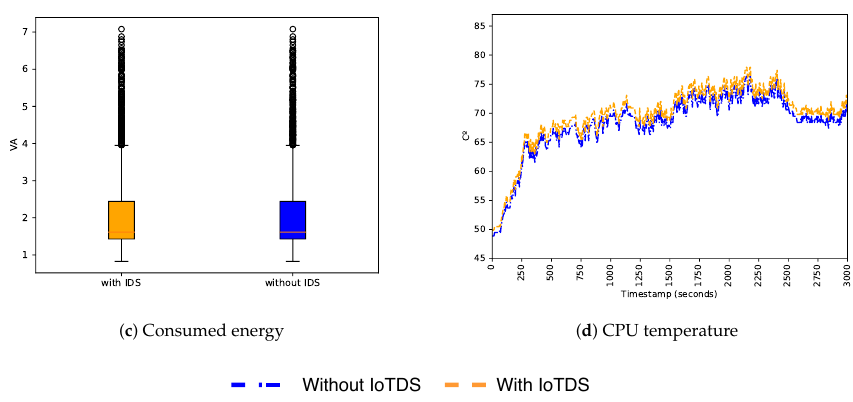
Figure 10. Behaviour of the MC profile infected with botnets regarding resource usage with and without the IoTDS.